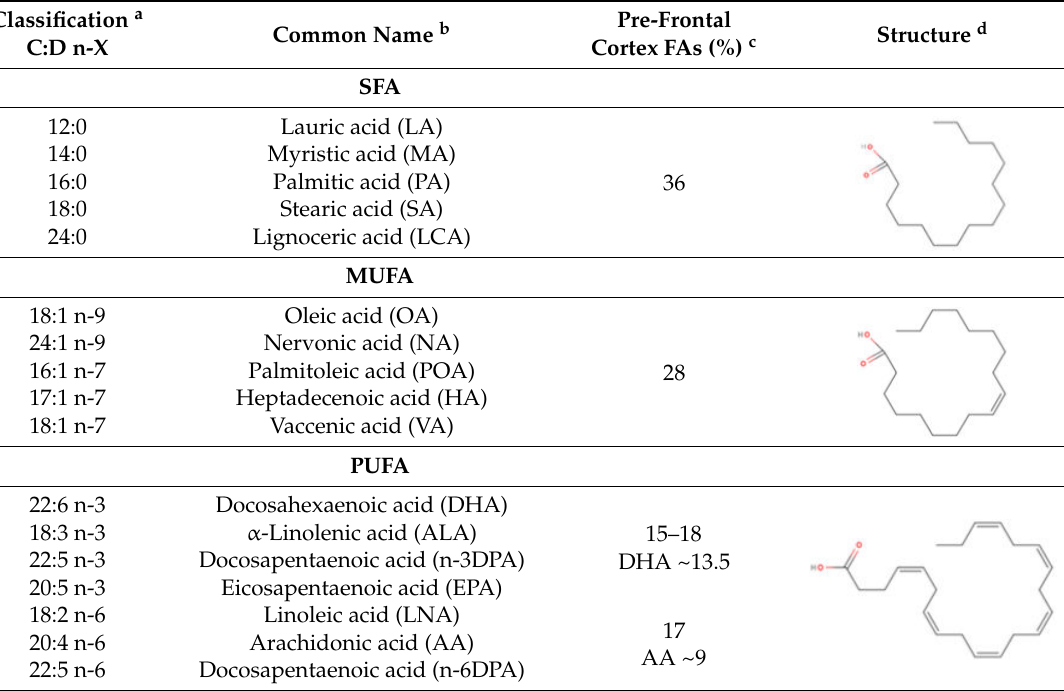
Table 1. Main fatty acids in human pre-frontal cortex. The most common brain fatty acids are grouped according to their unsaturation degree, reporting common names and chemical